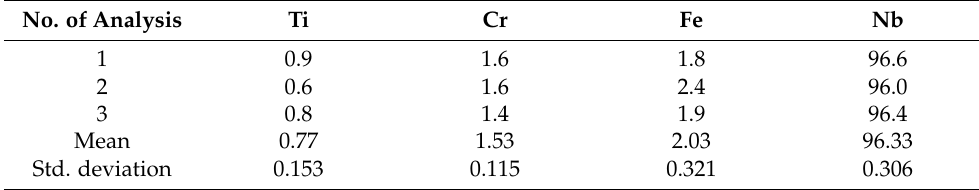
Table 8. Results of semi-quantitative EDX analysis of the NbX phase (wt.%).